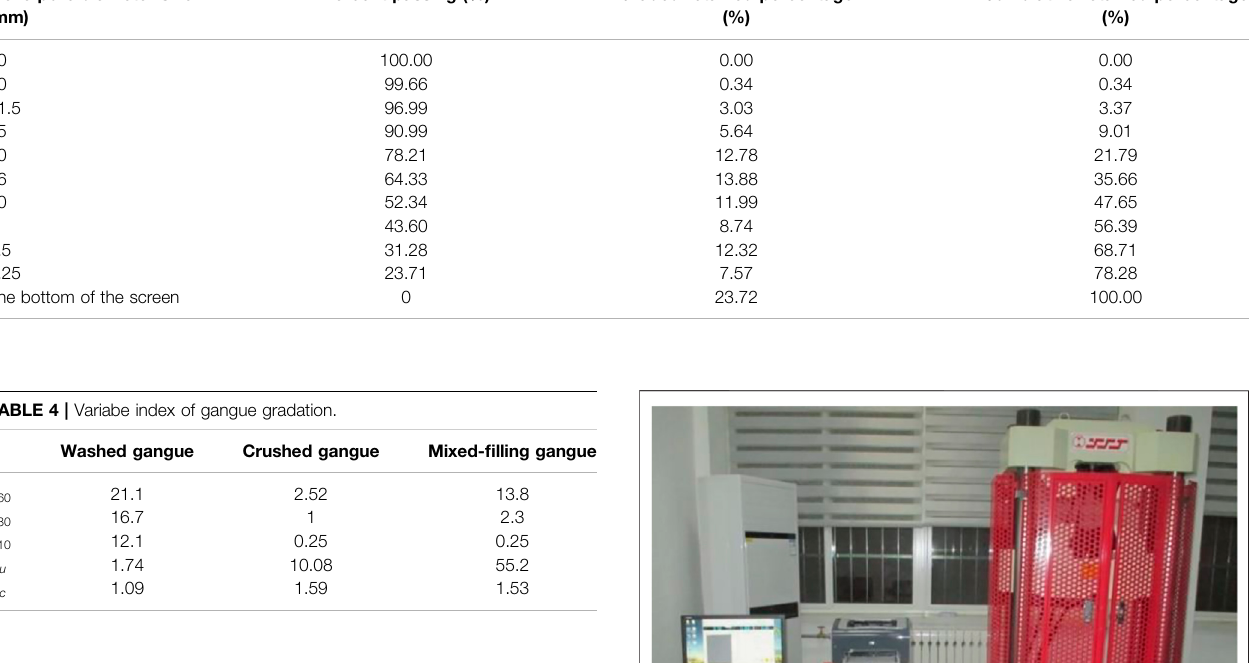
TABLE 3 | Gradation parameters for mixed- fi lling gangue. Sieve pore diameter size (mm)